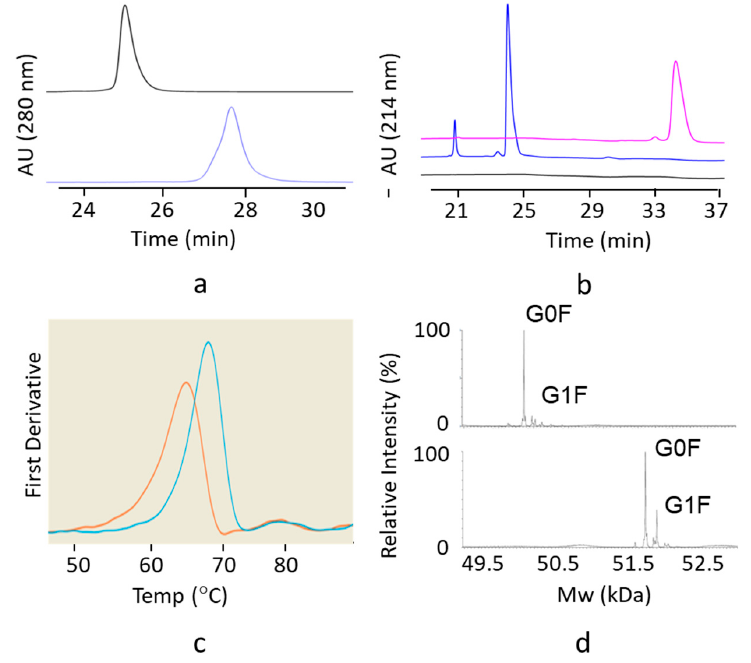
Figure 3. Biochemical and biophysical characterization of the hinge deleted IgG1 and its corresponding full-length control mAb by ( a ) SEC-UPLC coupled to UV (A280) and MALS. The UV elution profiles of the hinge deleted IgG1 molecule (bottom trace) and the corresponding full-length control (top trace) are shown. Molecular masses of 140 and 150 kDa were measured by MALS for the hinge deleted molecule and its full-length counterpart. ( b ) Nonreduced CE-SDS coupled to UV (A280). Electropherograms of the bu ff er control (bottom trace), hinge deleted IgG1 molecule (middle trace) and the corresponding full-length control (top trace) are shown. ( c ) Di ff erential Scanning Fluorimetry. An overlay of the melting profiles of the hinge deleted IgG1 molecule (orange) and the corresponding full-length control (teal) are shown. Melting temperatures / onset were 67.8 / 56.5 ◦ C for the hinge deleted molecule and 71.1 / 63.2 ◦ C for the full-length control. ( d ) Intact reduced LC–MS. Total Ion Counts of the hinge deleted IgG1 molecule heavy chain (top trace) and the corresponding heavy chain of the full-length control (bottom trace) are shown. The peak corresponding to the dominant Fc N-Glycan G0F and G1F species are shown.